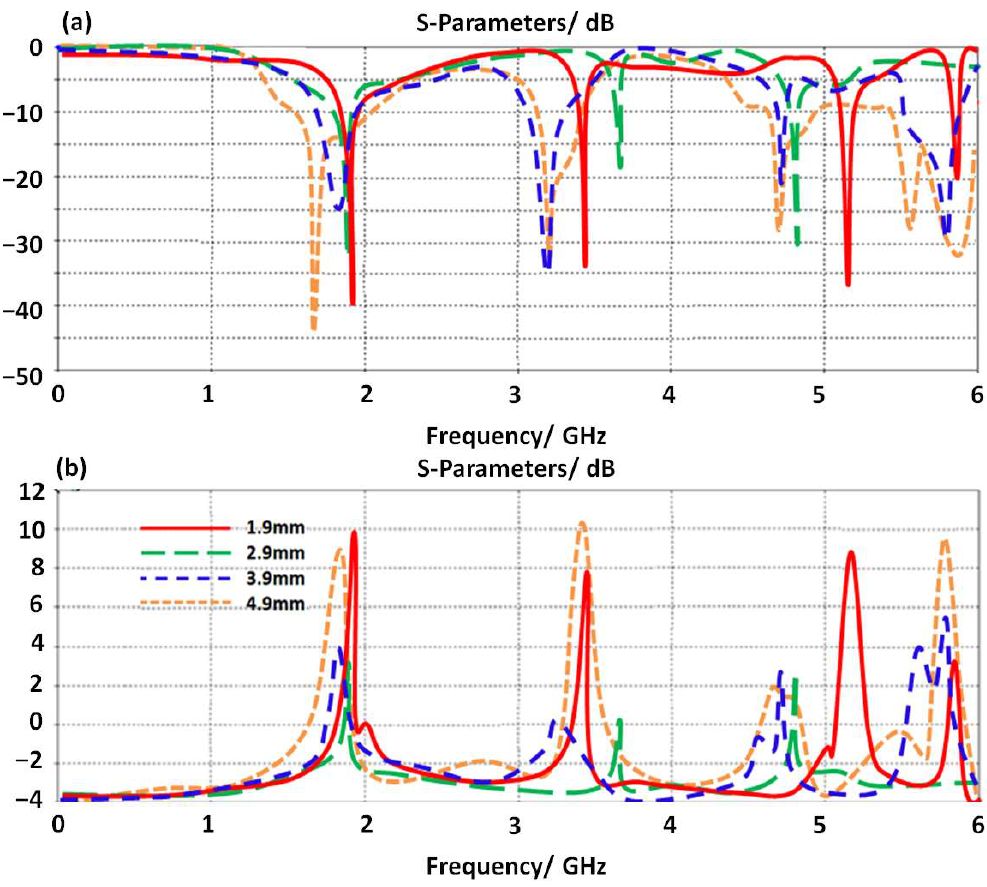
Figure 5. Antenna performance varying the ground plane length: (a) S 11 spectra and (b) gain.